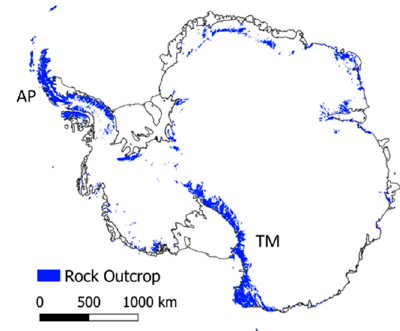
Figure 1. Distribution of ice-free land in Antarctica. The two areas with the largest proportion of ice-free land on the continent are named the Transantarctic Mountains (TM) and the Antarctic Peninsula (AP). Figure by A. Burton-Johnson using the Landsat 8-derived rock outcrop data of Burton-Johnson et al. (2016) [21].